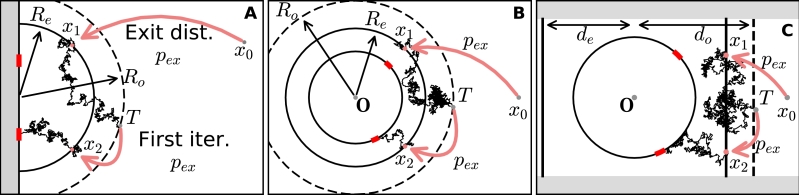
(A) hybrid stochastic simulation procedure for two windows on the boundary of half-space. Brownian particles injected at x0 are directly place on semi-circle with radius Re according to the exit pdf pex (red arrow). Inside the disk, trajectories are generated by the Euler's Scheme (40) until it passes outside the radius Ro > Re, where the trajectory is terminated at point T and restarted at a new position determined by the pdf pex. (B) same as in (A) but for a ball. (C) hybrid simulation scheme for windows on a disk in a strip. Brownian particles are injected at the boundary x = de based on the exit probability distribution pex. Trajectories with x > do or x < −do are re-injected at x = ±de according to pex (same procedure as in (A)). (For interpretation of the references to color in this figure legend, the reader is referred to the web version of this article.)